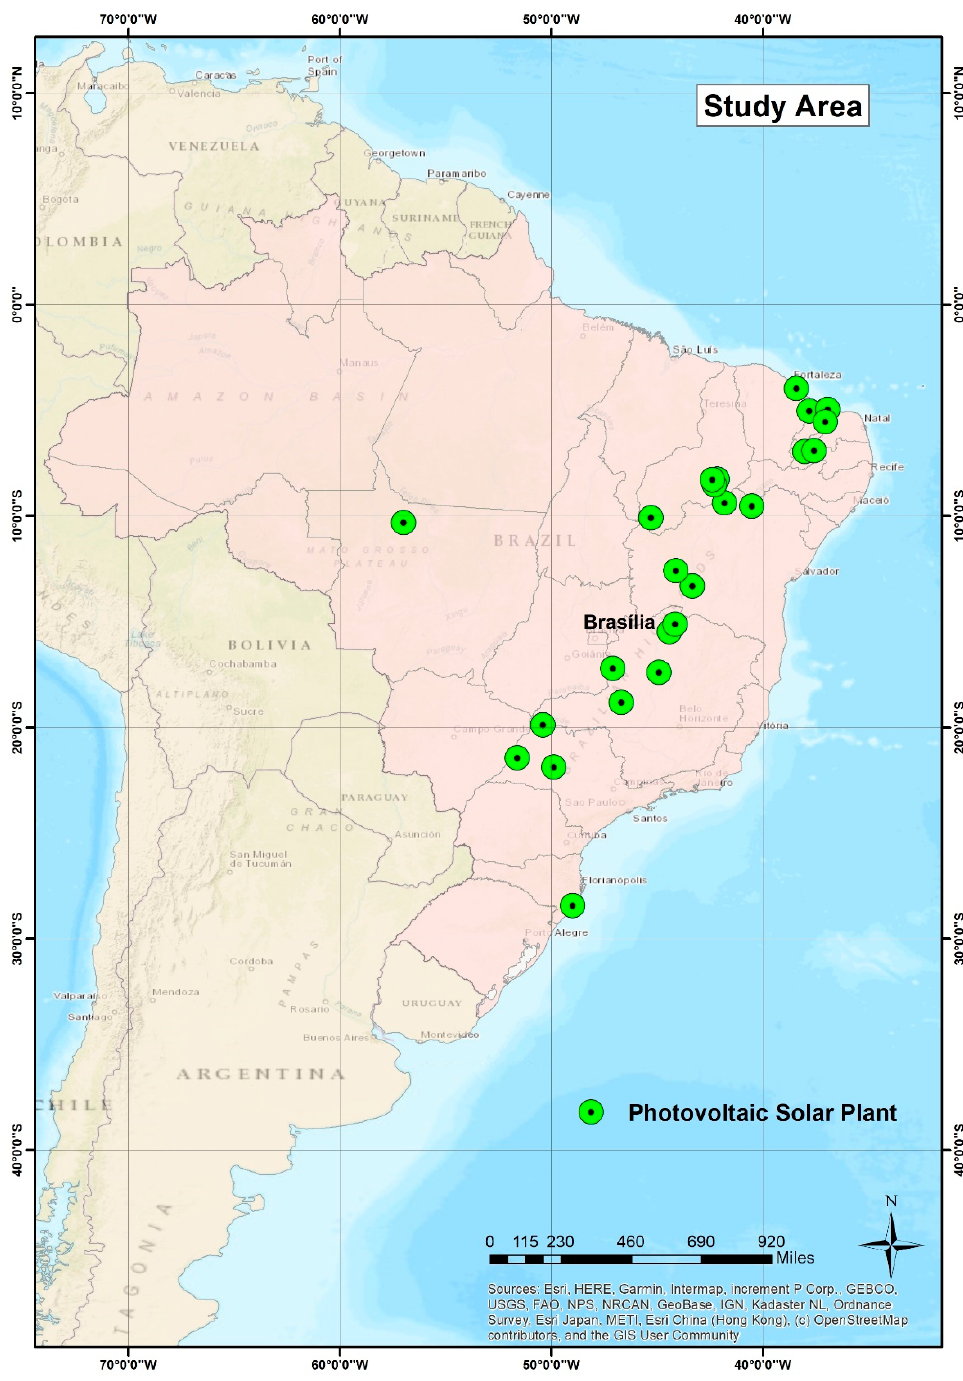
Figure 2. Study Area.